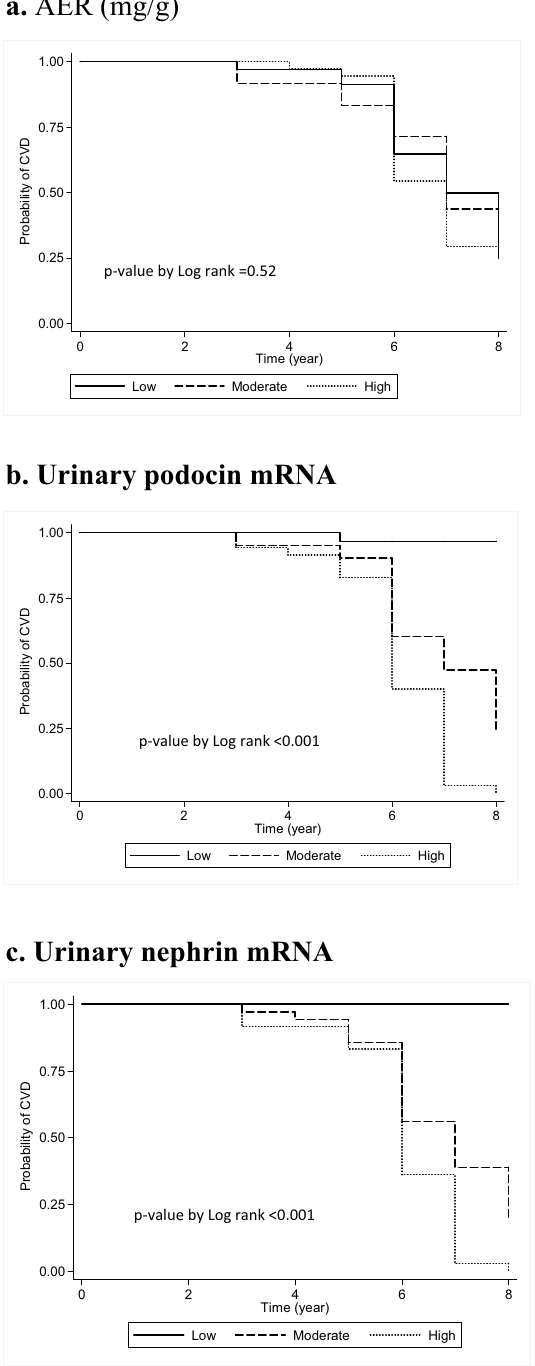
Figure 2. Time-to-Event analysis comparing the derived subgroups for the different biomarkers. Probability of CVD analyzed using Kaplan–Meier survival analysis with comparisons among the levels of AER (a; p value by Log rank = 0.52), urinary podocin mRNA (b; p value by Log rank < 0.0001) and urinary nephrin mRNA (c; p value by Log rank < 0.0001) using log-rank